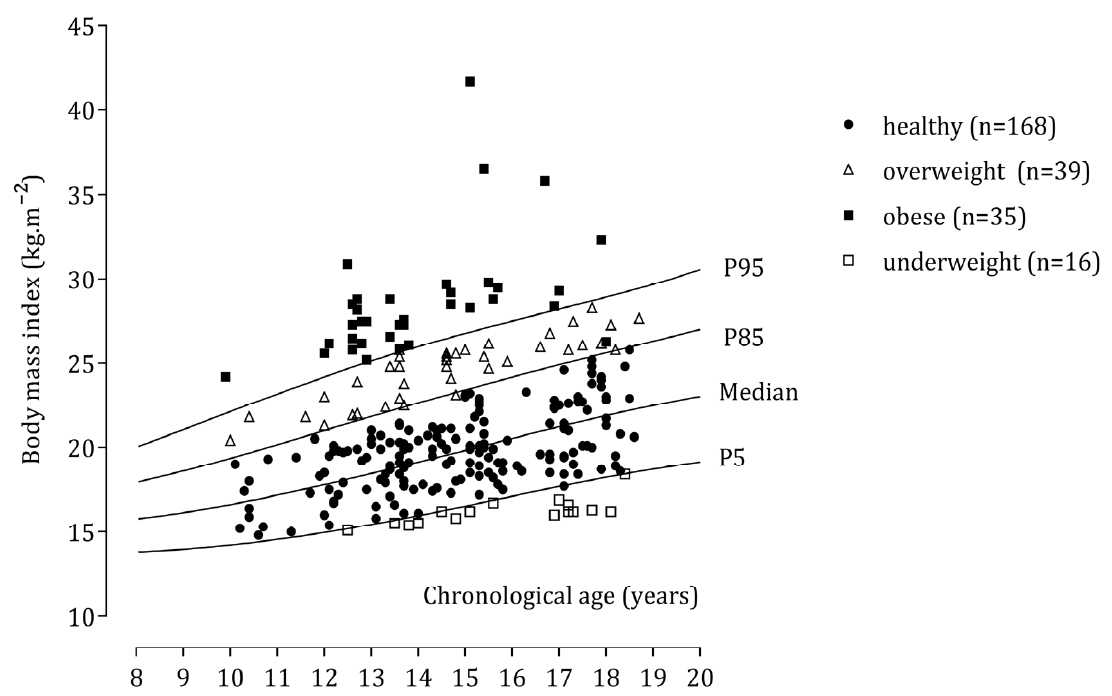
Figure 1. Body mass index of individual male school participants plotted relative to U.S. data.